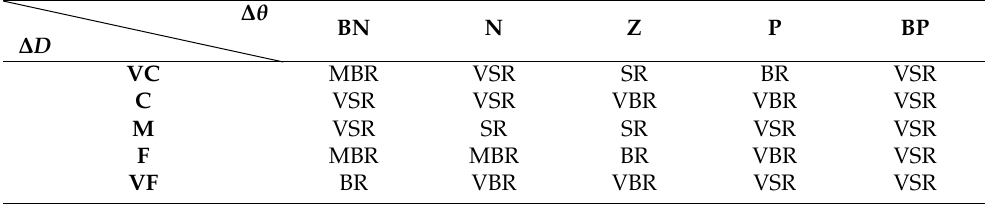
Table 13. The suboptimal rules for the left wheel angular velocity.